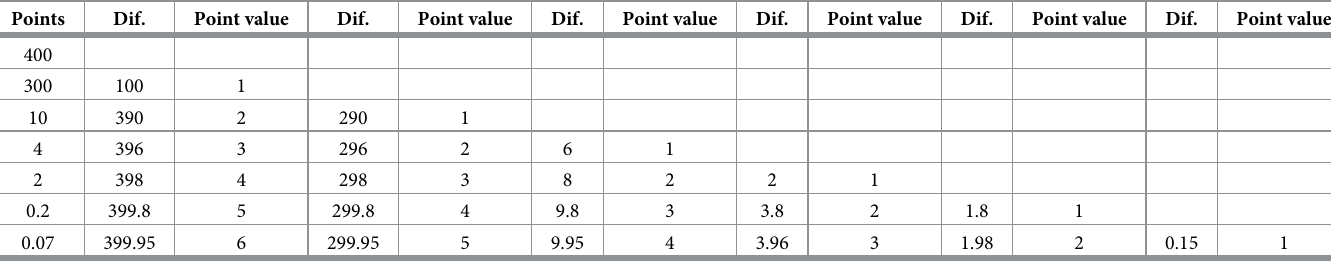
Table 1. Standardization of SWM-test points and values given to the evolutionary differences between them. Points